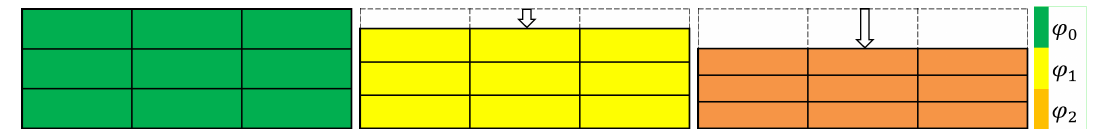
Figure 1. Schematic mesh deformation during the compression